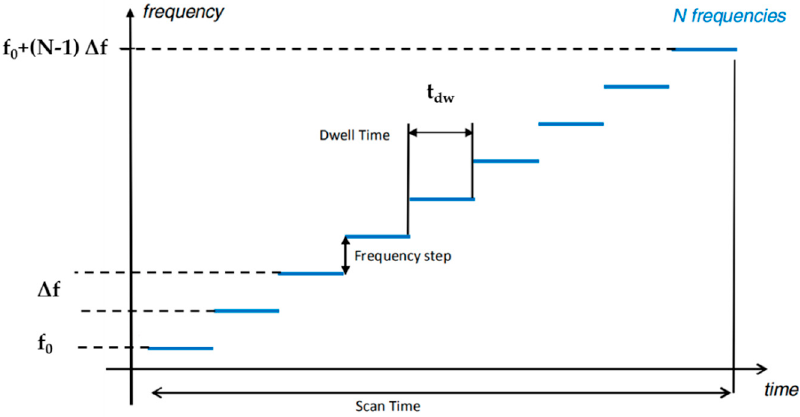
Figure 2. Measurement sequence and parameters of a stepped frequency system.